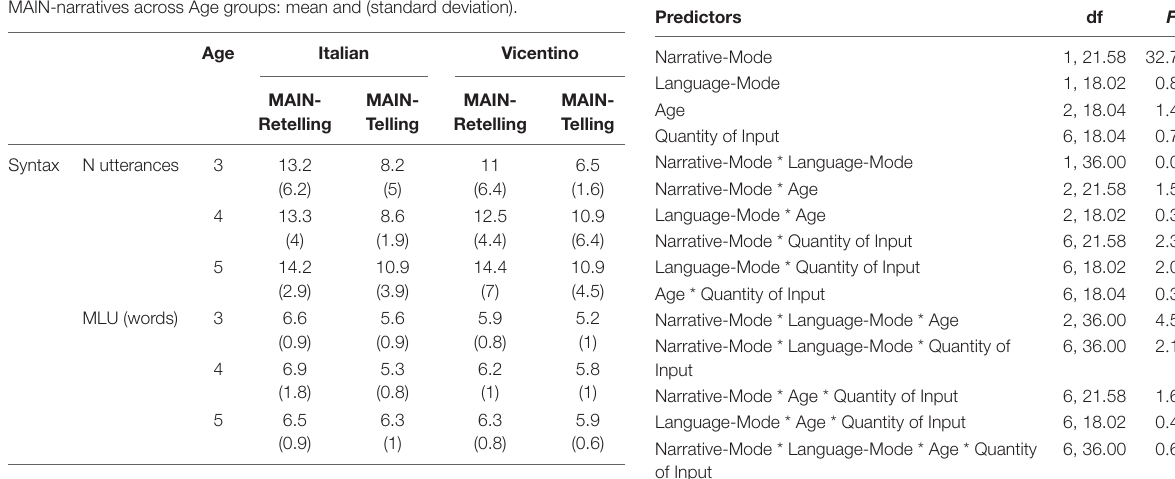
TABLE 6 | Descriptive statistics for Syntactic Measures in bilingual MAIN-narratives across Age groups: mean and (standard deviation).